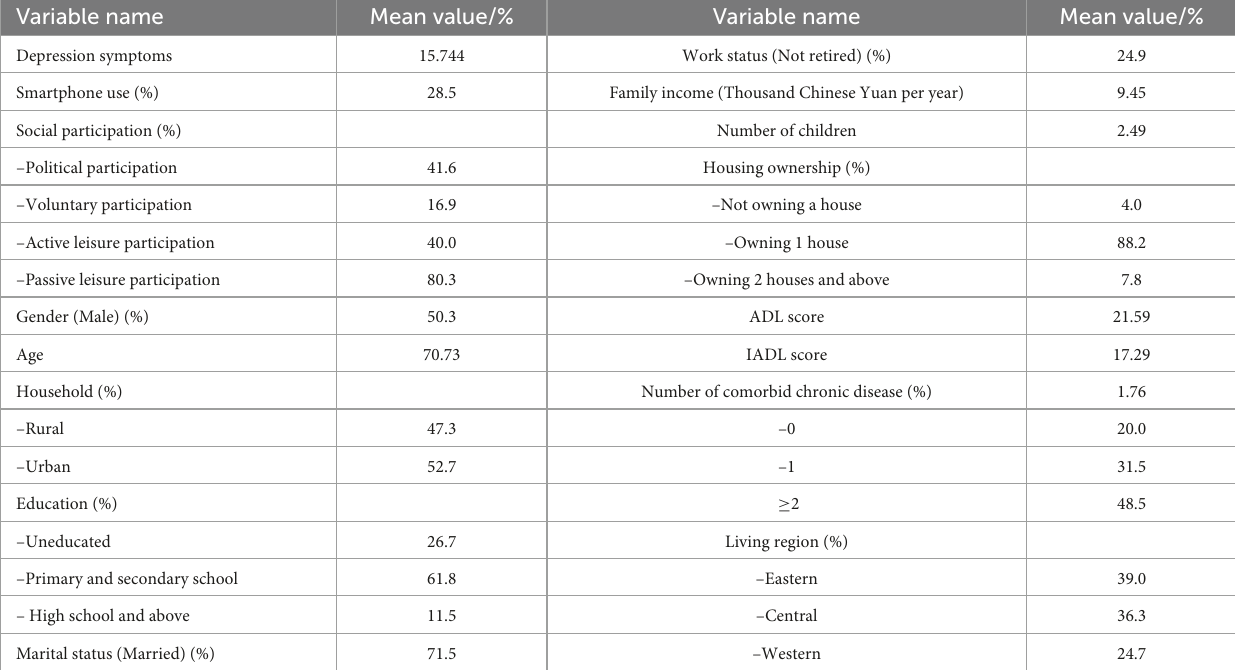
TABLE 1 Descriptive statistics of variables ( n =